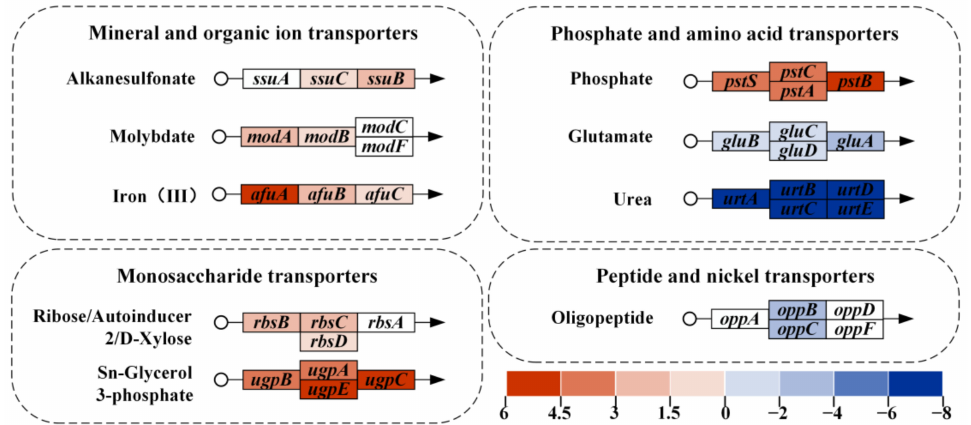
Figure 6. Heatmap (log 2 -fold change) of transcription levels of genes associated with ABC transporter proteins in the JSD1 strain. Shades of red and blue indicate upregulation and downregulation, respectively.